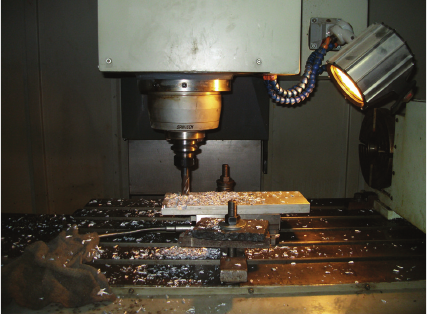
Figure 5: Vertical milling machining centre (TH5650) and